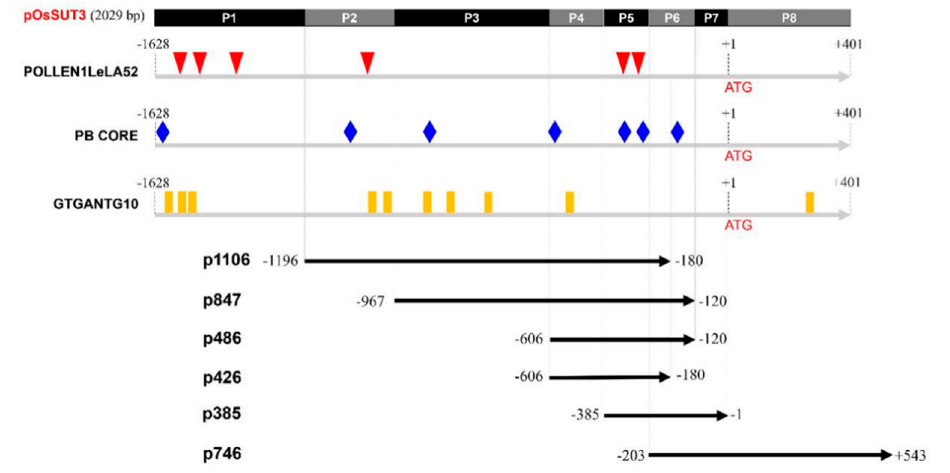
Figure 1. Schematic representation and pollen-specific motifs of various pOsSUT3 deletion constructs (p1016, p847, p486, p426, p385, and p746) used to transform rice. The numbers on the left indicate the upstream end of the promoter fragment present in each construct. The downstream end was on the right side. The top rectangle indicates the full length OsSUT3 promoter named pOsSUT3. P1–P8 represents the eight parts from pOsSUT3 divided according to pollen-specific elements. Different colored symbols represent the position of three pollen-specific elements, POLLEN1LeLA52, PB CORE, and GTGANTG10.